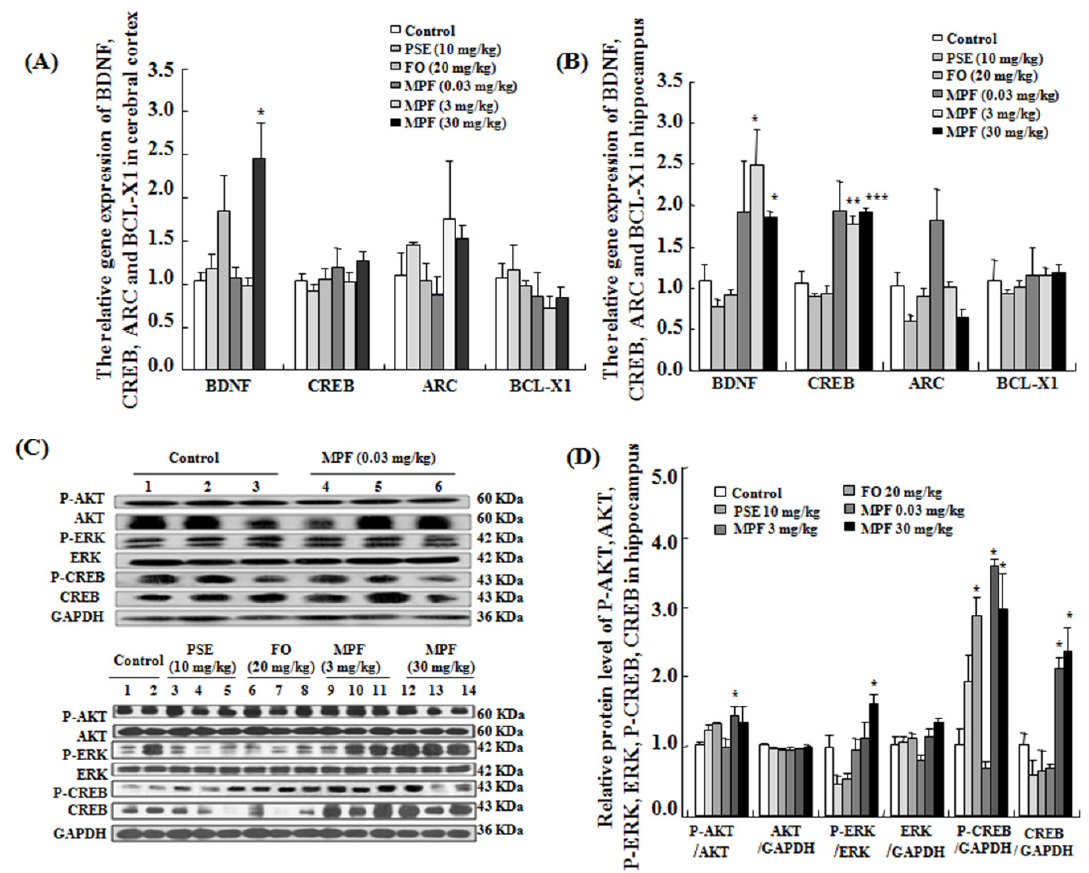
Figure 6. Effects of PSE, FO, and MPF on gene expression, and Western blot analysis in the cerebral cortex and hippocampus. Effects of PSE, FO, and MPF on expression of CREB, BDNF, ARC, and BCL-X1 in the cerebral cortex ( A ) and the hippocampus ( B ), and phosphorylation of AKT, ERK, and CREB proteins in the hippocampus ( C and D ). Each value represents mean ± SEM of seven mice. *, ** and *** indicate significant difference relative to the control at the same time point at p < 0.05, p < 0.01 and p < 0.001, respectively.